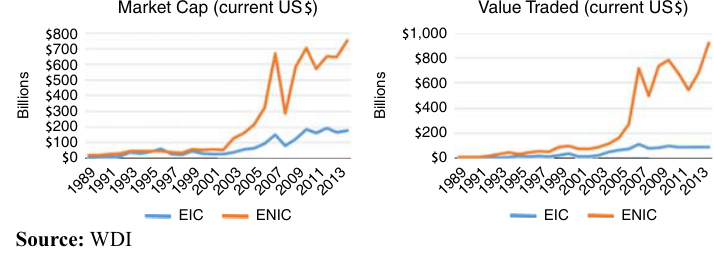
Figure 1. Illustration of stock market development trends in EIC and